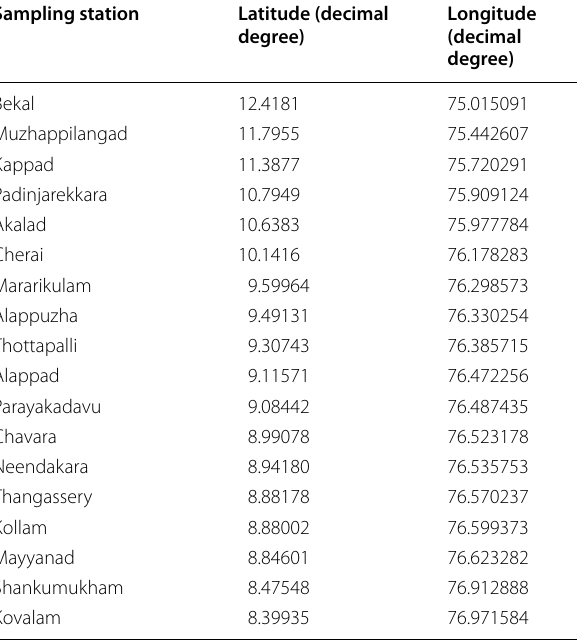
Table 1 Latitude and longitude of the sampling stations Sampling station